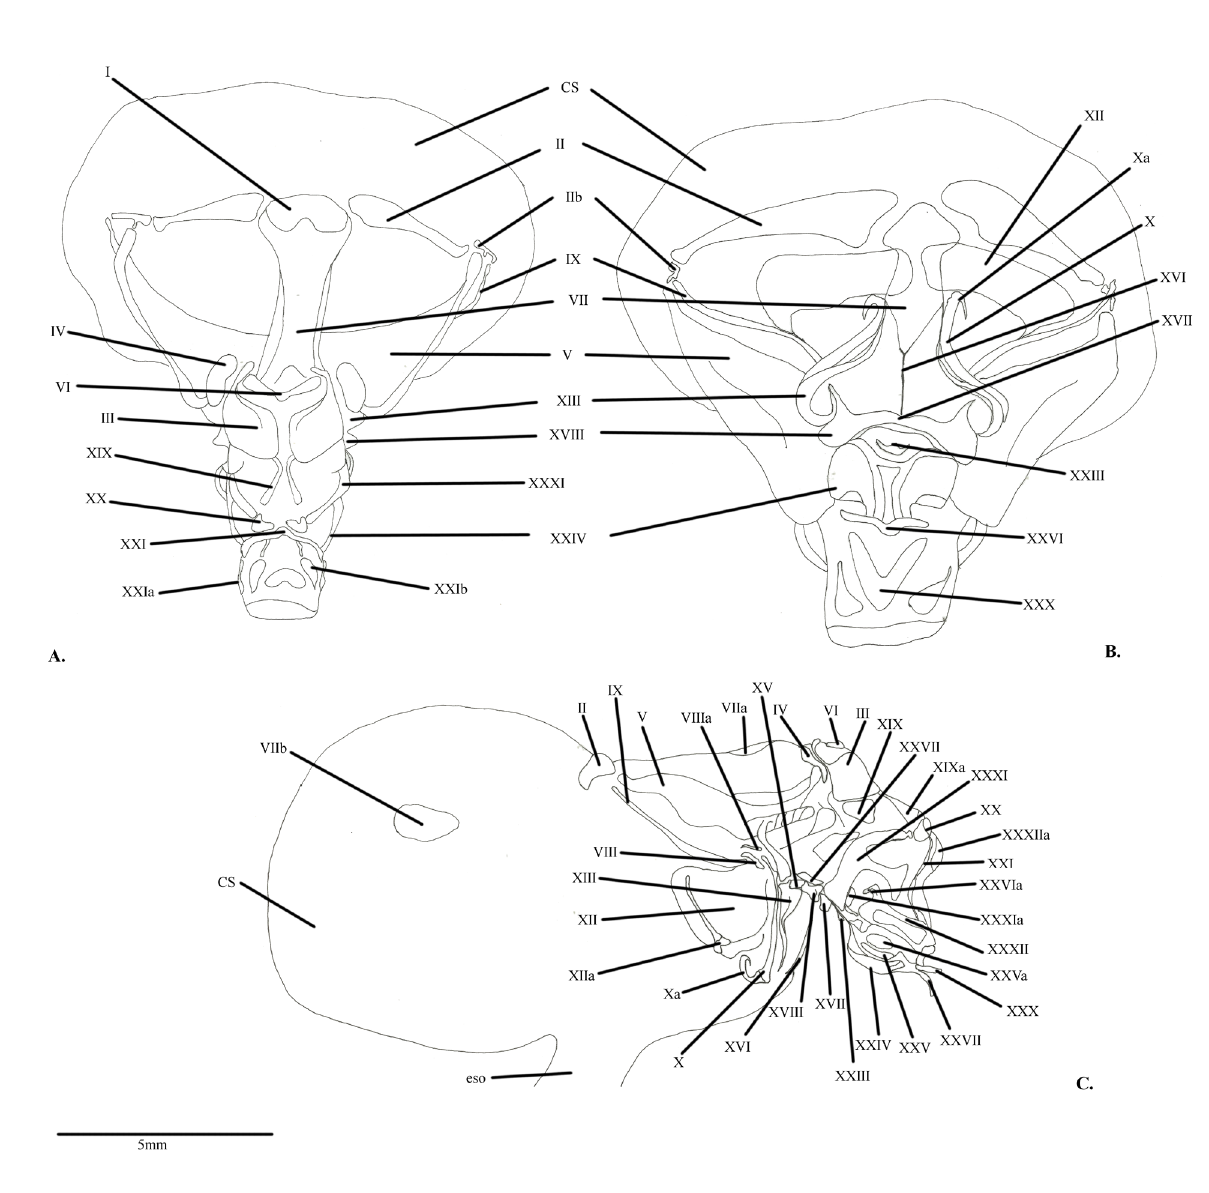
Figure 3. Moreirocarcinus emarginatus (H. Milne Edwards, 1853), cardiac and pyloric chambers of the foregut. A, Dorsal view; B, ventral view; C, lateral view. Abbreviations: CS, cardiac sac; eso, esophagus; see Tab. 2 for the nomenclature of the